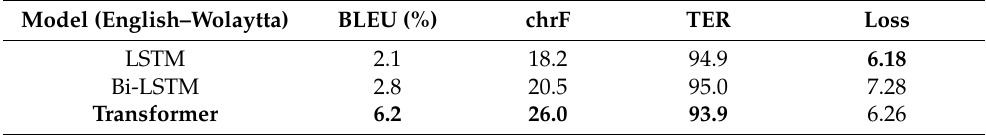
Table 5. BLEU, chrF, and TER scores of baseline models in English–Wolaytta translation. Model (English–Wolaytta)